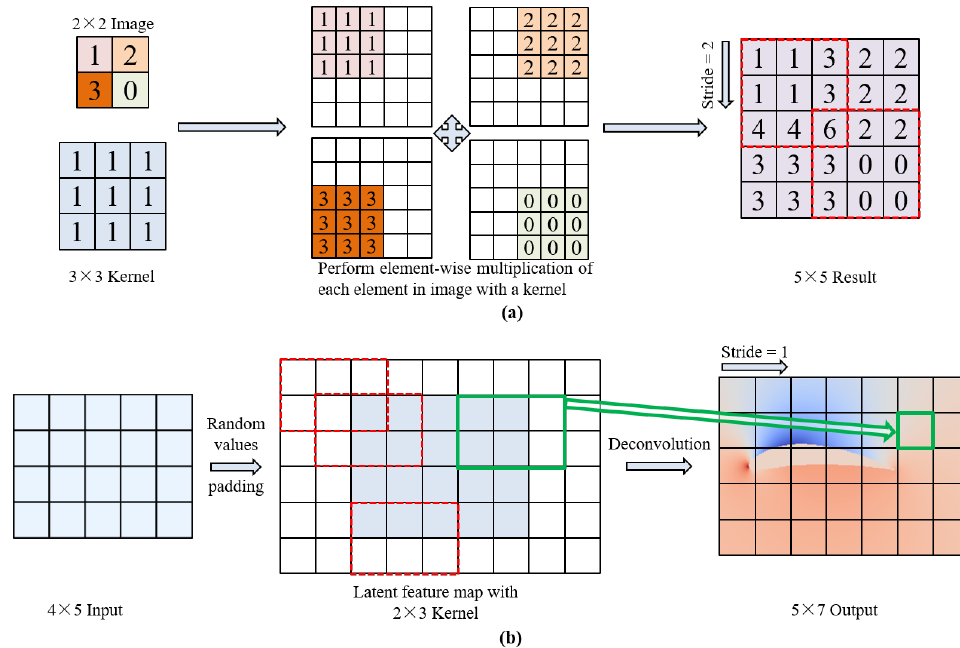
Figure 4. The schematic of a deconvolutional layer: ( a ) computation procedure of a 2D deconvolution; ( b ) operating flow of a deconvolution layer (numbers are for illustration purpose only).